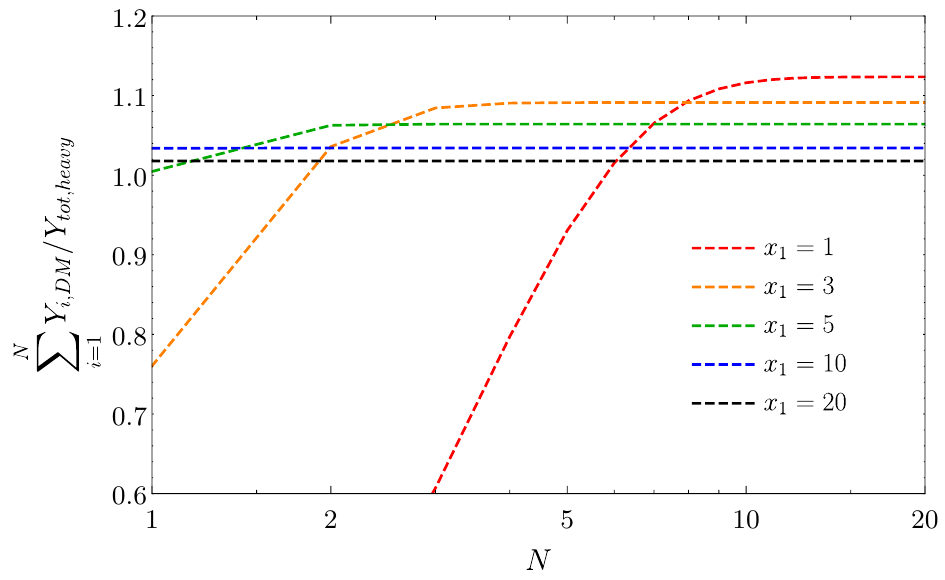
Figure 1. Comparison of the numerical result obtained summing up the Yields for each KK mode with the analytic approximation of eq. (3.8) for different values of x 1